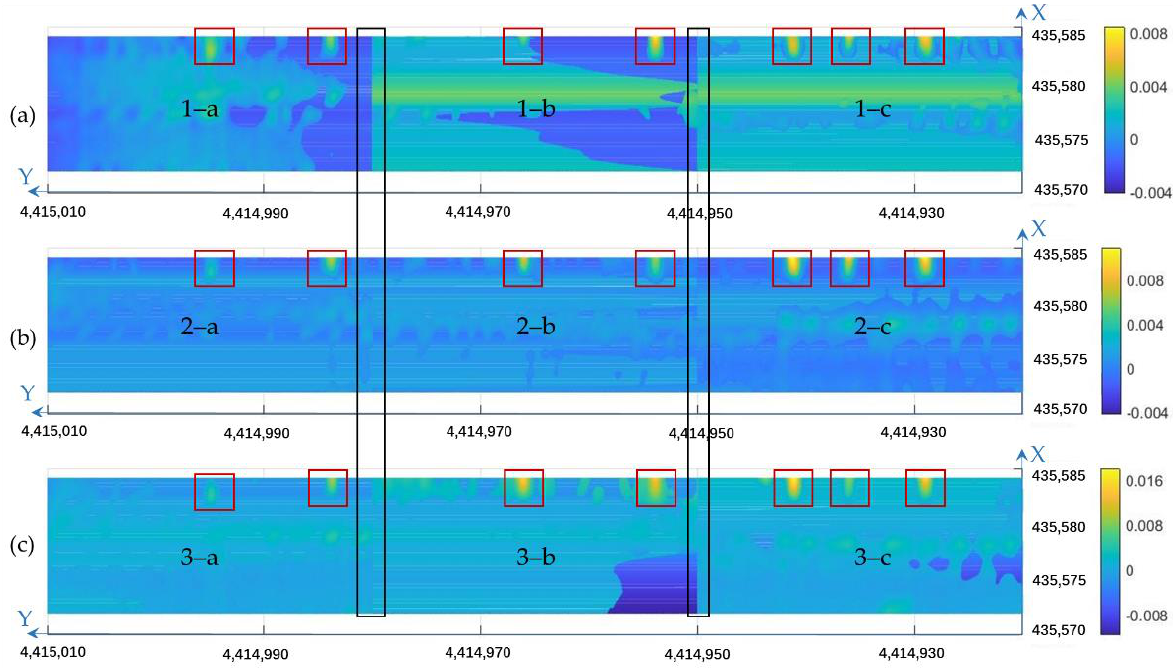
Figure 17. Height difference results (negative, m): ( a ) 0 – 5 mm; ( b ) 0 – 10 mm; ( c ) 0 – 15 mm.